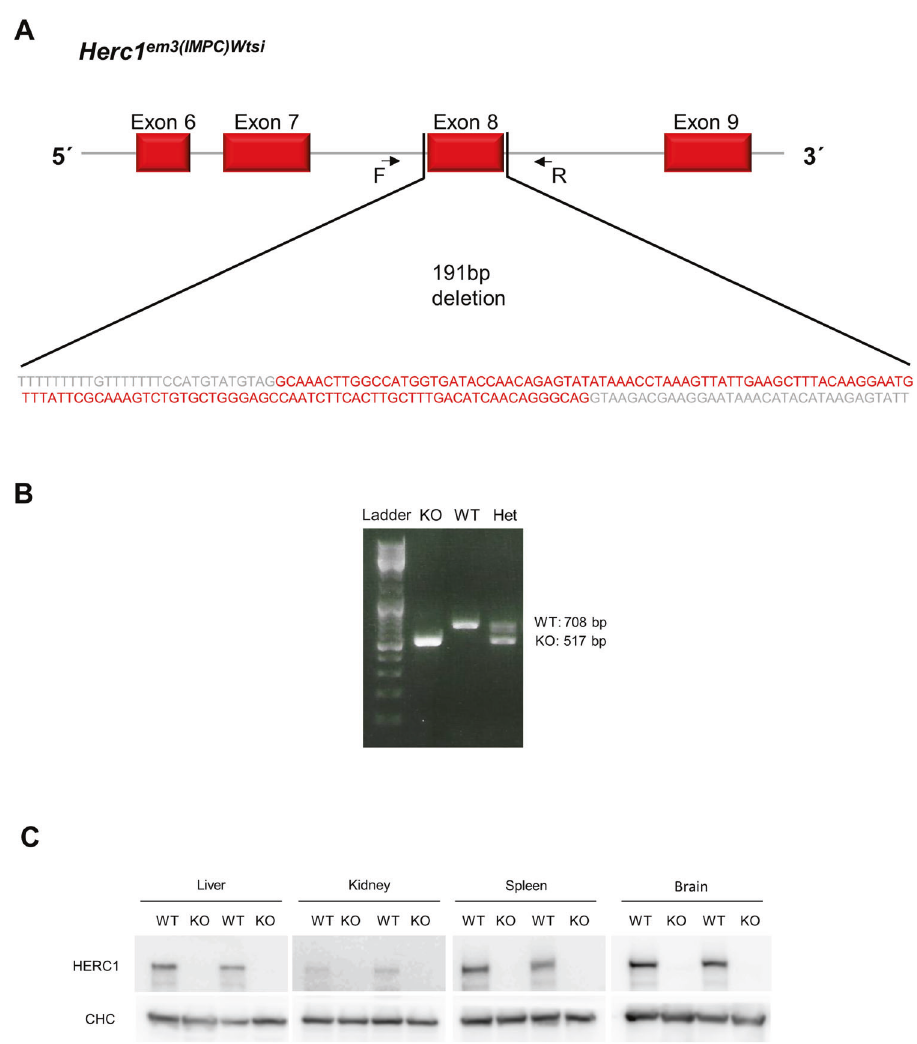
Fig. 2 Herc1 -knockout mouse. A A mouse C57BL/6N- Herc1 em3(IMPC)Wtsi /Wtsi model was generated at the Wellcome Trust Sanger Institute. A Crispr/Cas9 mediated deletion resulted in a 191-bp deletion that included exon 8 on the Herc1 gene. B Genotyping. Representative PCR analysis with the Forward (F) and Reverse (R) primers shown. The Thermo Scienti fi c (#SM0331) DNA Ladder mix was used as a molecular weight marker. C Lysates from the indicated tissues were analyzed by immunoblotting using speci fi c antibodies against the indicated proteins. Clathrin heavy chain (CHC) was used as the control protein. Het heterozygote, KO knockout, WT differentiation studied for 3 weeks (Fig. 1A). The downregulation of HERC1 protein expression by shH1 was maintained over the time studied (Fig. 1A, right). Under these conditions, HERC1 depletion increased protein levels of C-RAF and phosphorylated ERK and p38 (Fig. 1A, right). Alizarin Red staining, used to evaluate calcium deposits during osteoblastic differentiation, increased in control cells (Fig. 1B) and increased to a greater degree in HERC1 knockdown cells (Fig. 1B), consistent with the differences in cell morphology detected by light microscopy (Fig. 1A). We assessed the expression of osteoblast-speci fi c genes by RT-qPCR to con fi rm the stimulation of osteoblastic differentiation by HERC1 depletion, revealing a signi fi cant increase in mRNA levels of early markers, such as transcription factor Runx2 , in HERC1-depleted cells compared to control cells at 14 days (Fig. 1C). Furthermore, mRNA levels of later markers of osteoblastic differentiation, such as Sp7 (osterix) , Bglap (osteocalcin) , Alpl (alkaline phosphatase), and Col1a1 (collagen), were also signi fi cantly increased in HERC1- depleted cells compared to control cells at 21 days (Fig. 1C). Consistent with Alpl mRNA levels, alkaline phosphatase activity was greater in HERC1-depleted cells at 21 days (Fig. 1D).